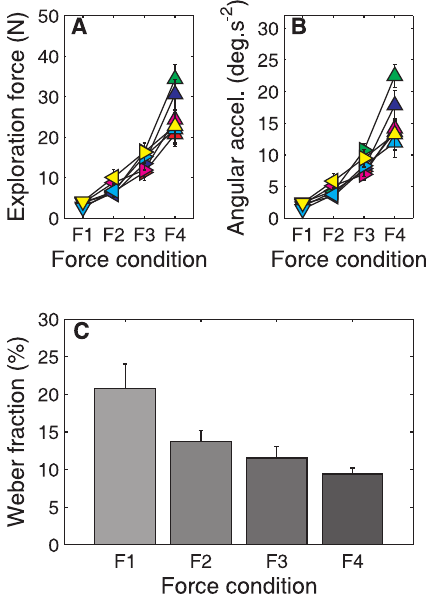
Figure 5. Results of Experiment 2. A: Magnitude of the exploration force for each participant in the four force conditions. The colors indicate individual participants; the error bars indicate one standard deviation. B: Magnitude of the angular acceleration (details as in A). C: Average Weber fraction in the four force conditions. The error bars indicate the standard error over